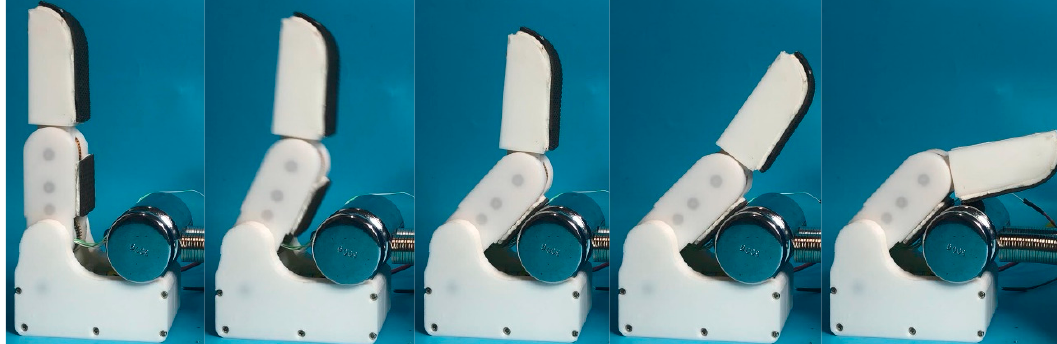
Figure 20. Motion process of the PASA mode.